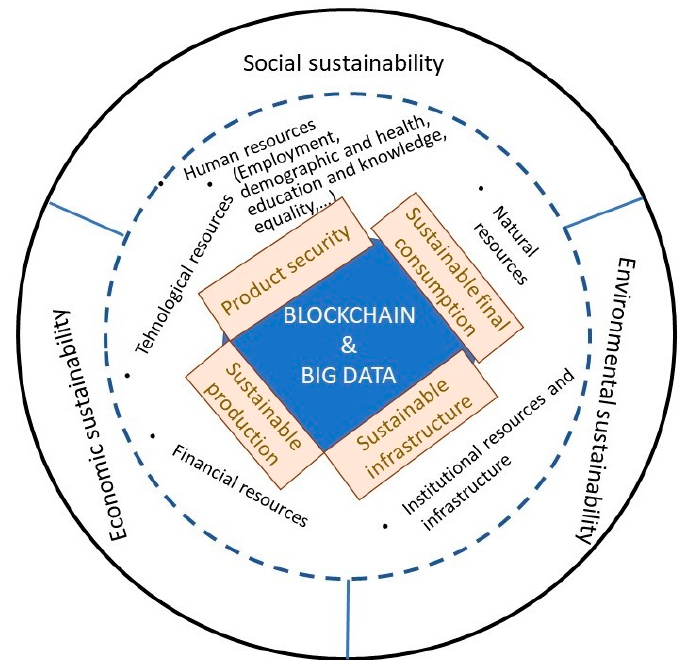
Figure 2. The framework for blockchain-based data management system for HILCSA. Source: Au- thors.